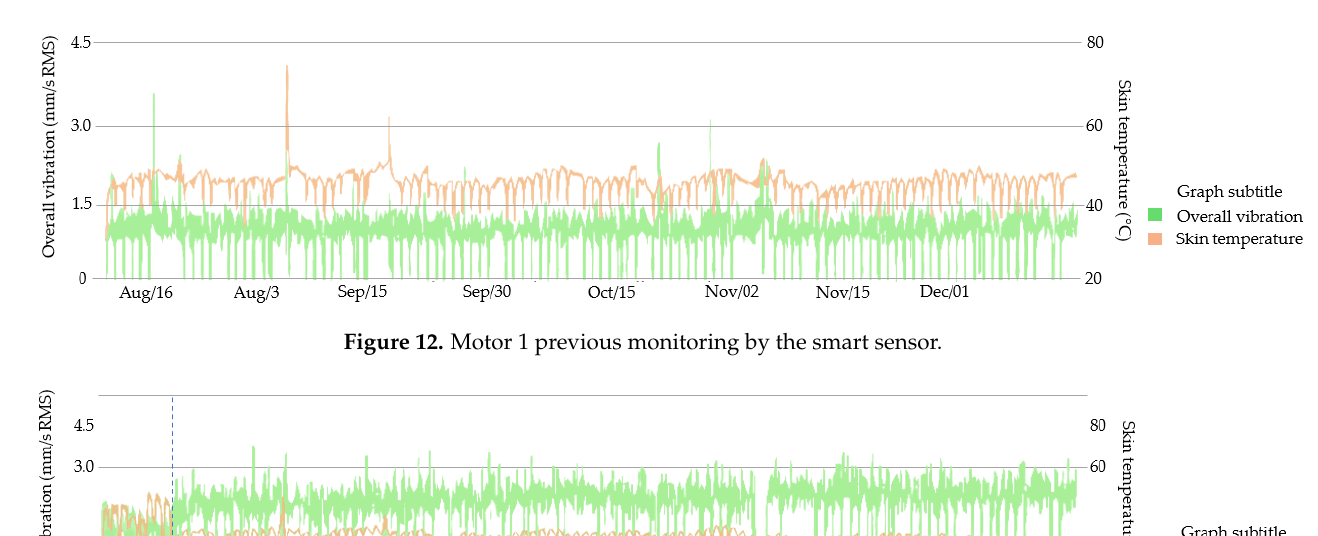
Figure 14. Motor 2 monitoring by the smart sensor.